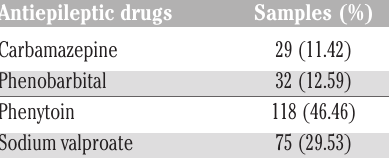
Table 2. Submission of blood samples for therapeutic drug monitoring classified by